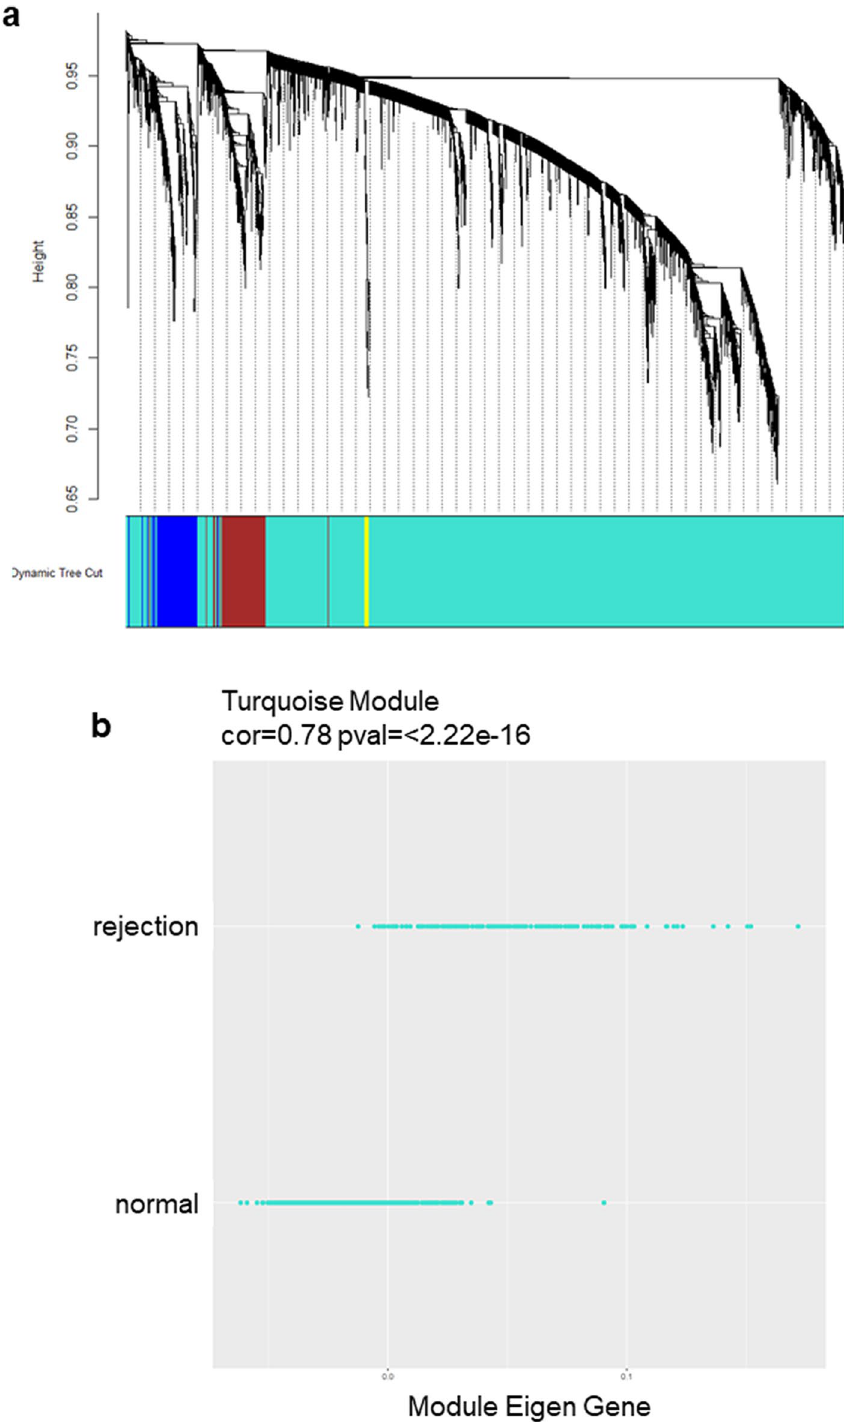
Figure 1. Weighted Correlation Network Analysis of transcript changes within cardiac allograft biopsies with rejection versus stable [GSE124897]. ( a ) Gene dendrogram and module colors for the top 5,000 genes with the most significant Wilcoxon test p value, comparing rejection to non-rejection/normal. The top 4 modules (turquoise, yellow, blue and brown) are shown. The branches indicate modules of interconnected gene groups. ( b ) Distribution of expression of genes within the Turquoise Module in biopsies with rejection versus non- rejection/normal. ( c – e ) Violin plots show the expression of inflammatory effector molecules and of leukocyte receptors for endothelial adhesion molecules in normal cardiac transplant biopsies and those with TCMR or ABMR. The backtransformed values for intragraft ( c ) proinflammatory cytokines TNF and IL1B. ( d ) endothelial adhesion and recruitment genes VCAM1, BST2, CD164/endolyn, CXCL1/GROα, CXCL9/MIG, CXCL10/IP-10, CCL2/MCP-1, CXCL8/IL-8; and ( e ) cognate leukocyte receptors SELPG/PSGL-1, ITGB2/LFA-1/Mac-1, and ITGA4/VLA-4 are